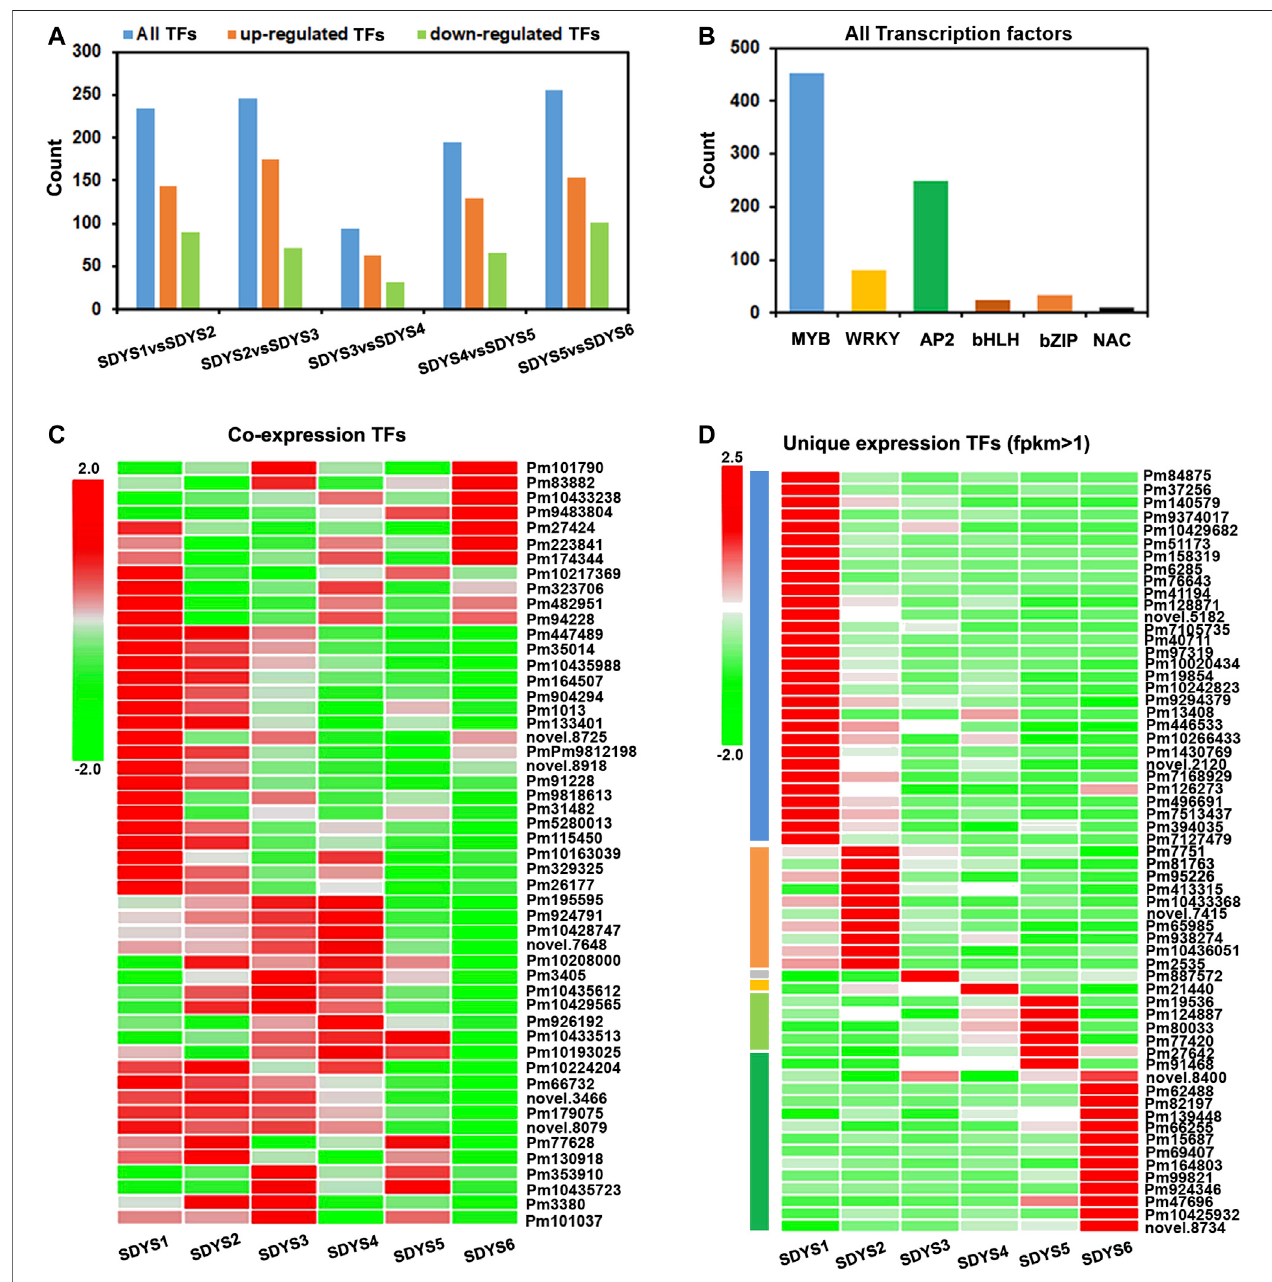
FIGURE9| DifferentiallyexpressedTFsrelated toembryodevelopmentof P.mongolica . (A , B) AllTFsidenti fi edinpairwisecomparisons. (C) HeatmapofTFsfrom 1,279 DEGs shared in all six groups. (D) Heat map of TFs from each embryo development-speci fi c DEG.